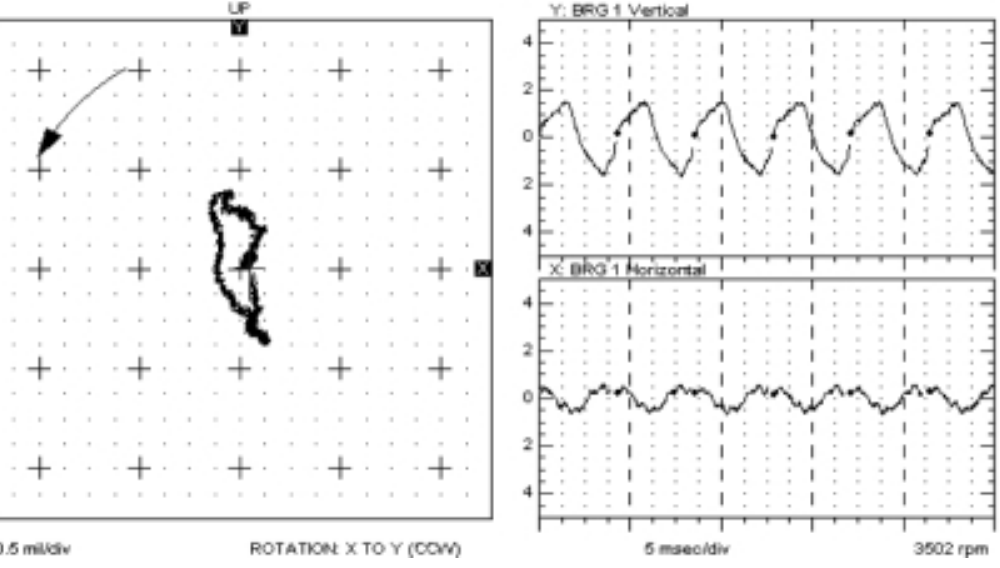
Fig. 5. Orbit for un-cracked shaft with 8 kg vertical hanging side